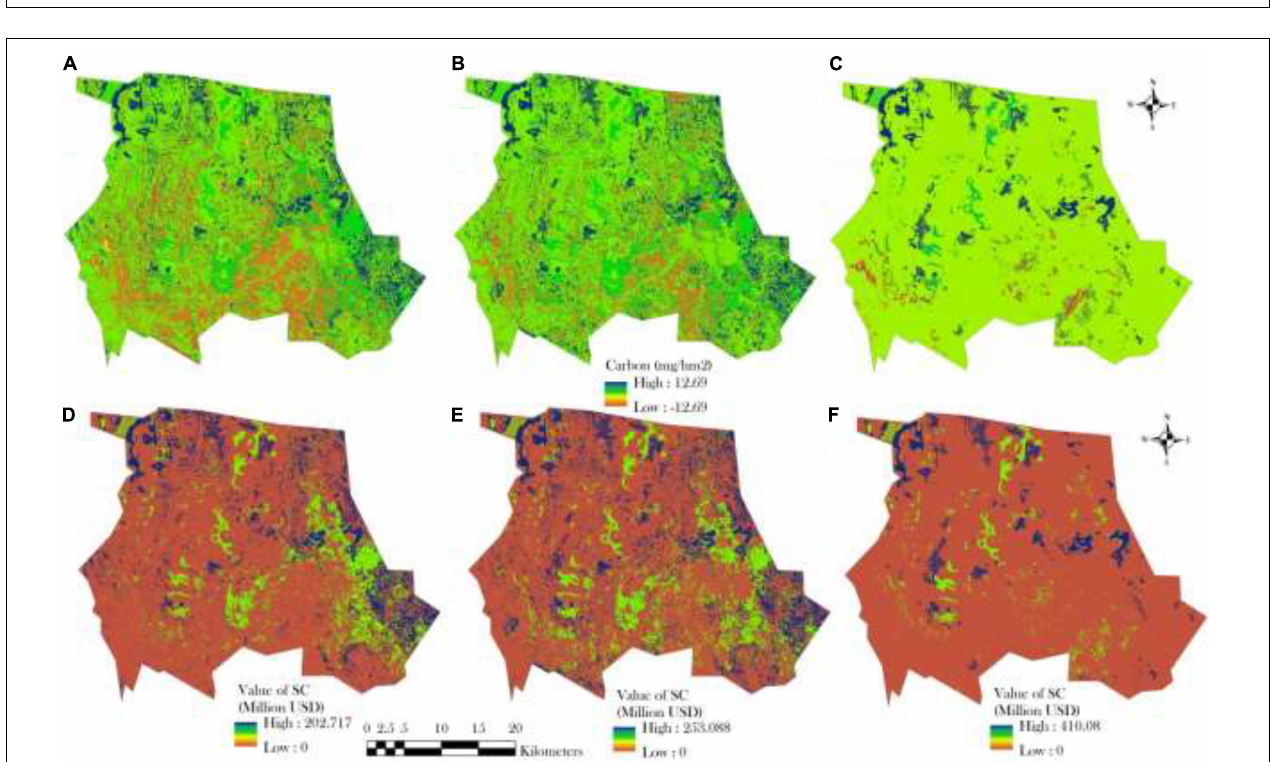
FIGURE 9 | Modeling of carbon sequestration using InVest model during (A) 1990–2040, (B) 2000–2040, and (C) 2020–2040; valuation of carbon sequestration during (D) 1990–2040, (E) 2000–2040, and (F)